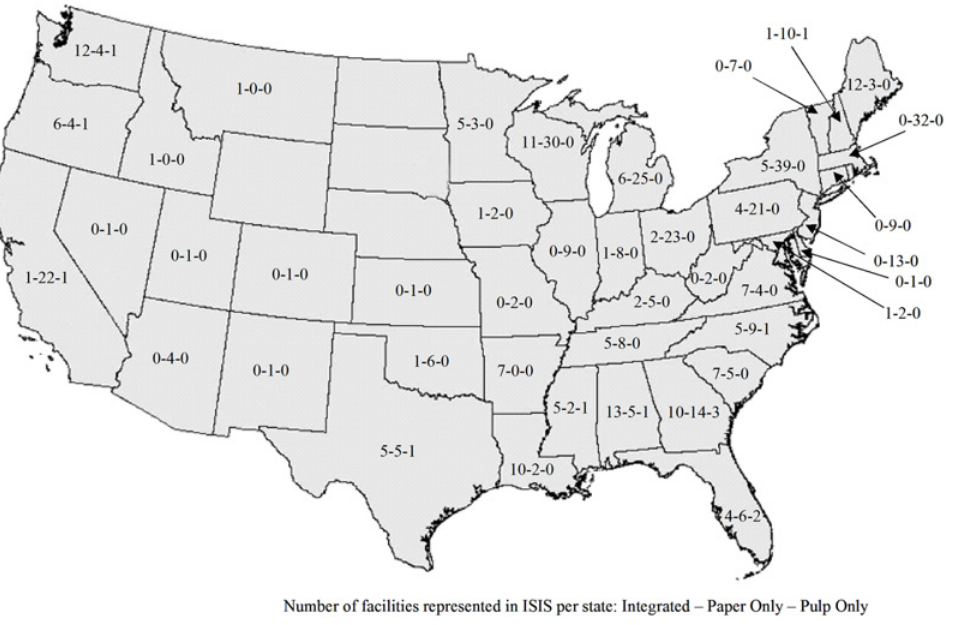
Fig 5. Map of pulp and paper facilities representing in ISIS